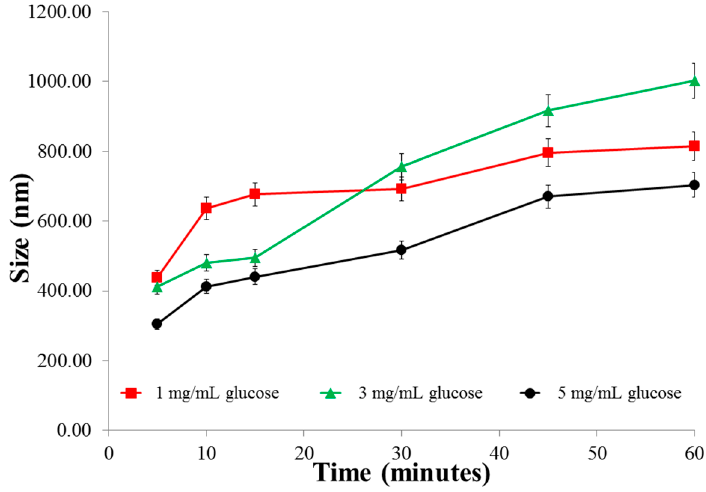
Figure 3. Size changes of the nanoparticles in various concentrations of glucose as a function of time.